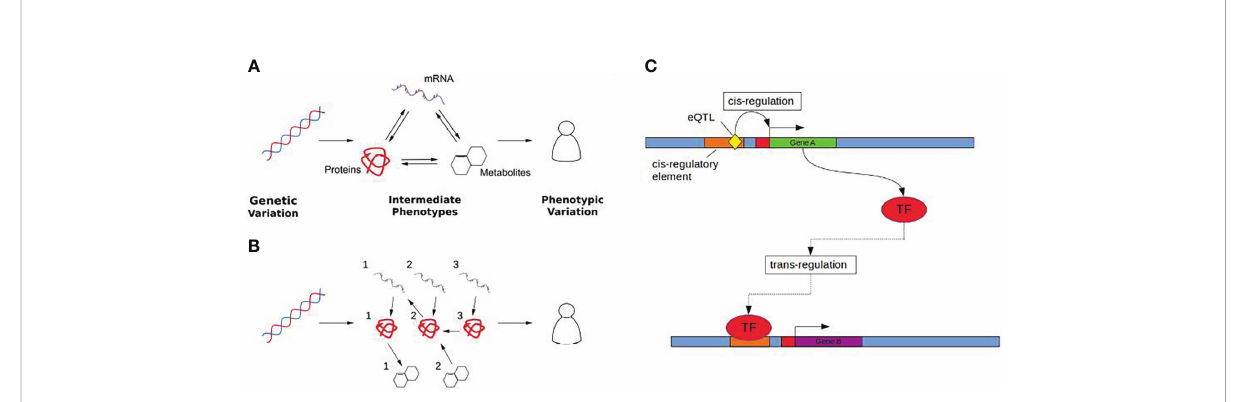
FIGURE 1 (A) Genetic variation (Left) in fl uences complex traits (Right) through quantitative changes in intermediate phenotypes (Middle). Molecular interactions are shown as arrows, where the direction of the arrow indicates the direction of the fl ow of biological information. (B) Intermediate phenotypes can be modelled as biological networks using causal inference to uncover directed relationships between the molecular determinants that mediate the effect of genetic changes on complex traits. (C) Cis and trans gene regulation. Gene A (green) encodes a transcription factor (TF) which regulates the expression of gene B (purple). The eQTL (yellow), acts as a cis-eQTL for gene A by causing a change in the sequence of gene A ’ s cis-regulatory element (orange) which may either increase or decrease the binding af fi nity of any corresponding TFs. The same eQTL is a trans-eQTL for Gene B as by changing the expression of the TF encoded by gene A, this in turn in fl uences the expression of gene